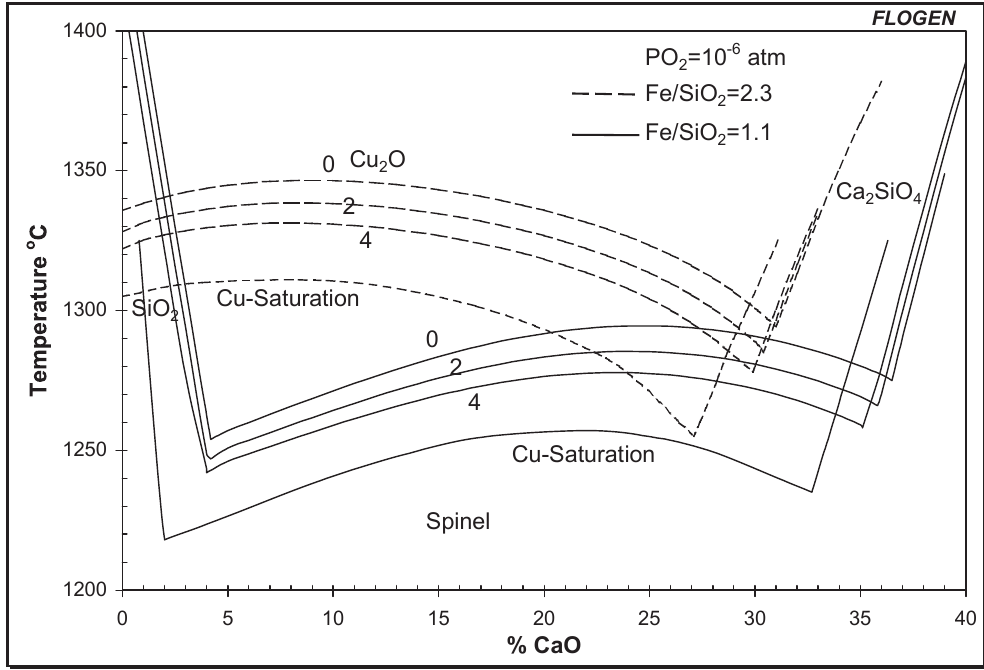
D 10 (cid:3) 6 atm and several constant Fe = SiO 2 2